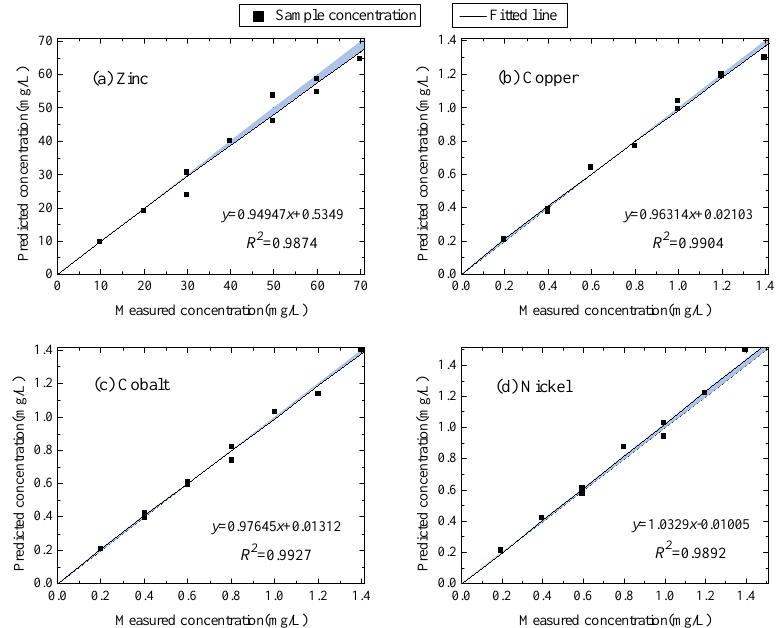
Figure 7. The fitting curves of zinc ( a ), copper ( b ), cobalt ( c ), and nickel ( d ) ions in the test set (10